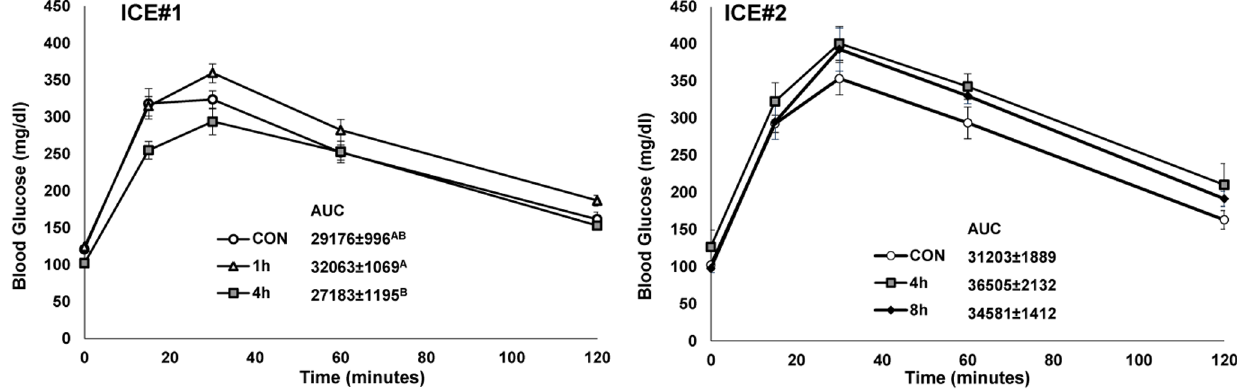
Figure 3. Transient improvement in glucose tolerance by cold exposure. In ICE # 1 (top) and ICE # 2 (bottom), intra-peritoneal glucose tolerance tests (1 g/kg) were performed in the overnight-fasted mice. In ICE # 1, the ipGTT was conducted the day after cold exposure, while in ICE # 2 it was conducted on the second day following cold exposure. The inset shows the mean area AUC in mg/dl . min 6 SE, N=8/group. Levels not connected by same letter are significantly different (P ,